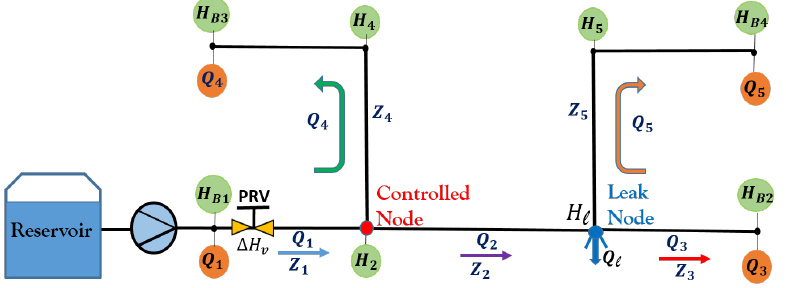
Figure 4. Case 3: Branched water distribution